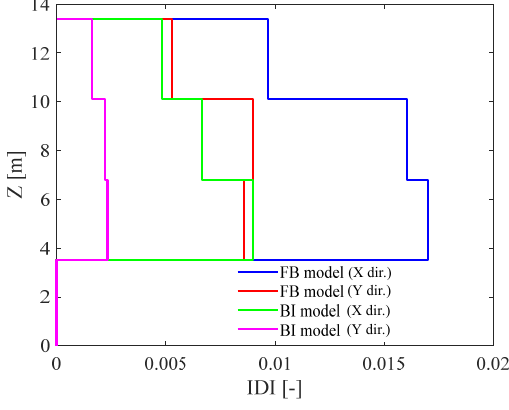
Figure 11. Comparison between the IDIs.